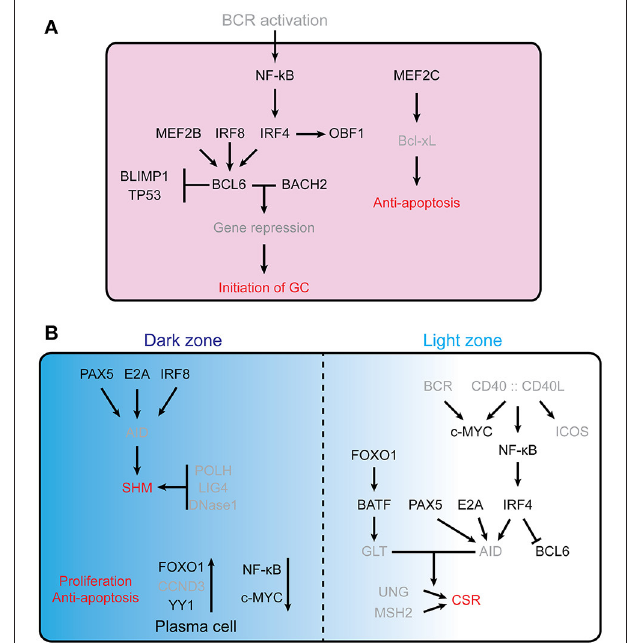
FIGURE 1 | Transcription factors controling GC formation. (A) Initiation of the GC reaction in follicular B cells. For clarity, TFs are indicated in black, while other molecules (e.g., receptors, cytokines, etc…) are in gray. B cell lymphoma 6 (BCL6) is essential for the initiation of germinal center, MEF2B, IRF8, IRF4, BLIMP1, and TP53 are involved in regulating the expression of Bcl6 . BCL6 and Bach2 cooperatively ( 12) repress gene expression and thus allow the establishment of the germinal center B cell program. MEF2C is required for B cell survival post-antigen stimulation by upregulating the Bcl2l1. (B) Schematic representation of the dark zone and light zone of the GC. The different TFs involved are indicated, as well as some of the processes regulated (SHM, Proliferation, anti-apoptosis, CSR), see text for further details. In the GC DZ, AID is a key enzyme for SHM; its expression is controlled by PAX5, E2A, and IRF8. POLH, LIG4, and DNaseI are required for SHM and are highly expressed in DZ B cells. FOXO1 is a key factor for maintaining the GC DZ B cell program, CCND3 is preferentially expressed in GC DZ B cells and YY1 is required for GC DZ B cell proliferation and survival. NF- κ B signaling and c-Myc are not essential for GC DZ B cells. In the GC LZ, CD40 signaling stimulated NF- κ B further stimulates IRF4 expression, which suppresses Bcl6 gene ( 13, 14). PAX5, E2A, and IRF4 are key factors in regulating AID level. BATF, a downstream target of FOXO1, regulates germline transcripts (GLTs) in centrocytes. GLT levels are highly correlated with accessibility of AID in